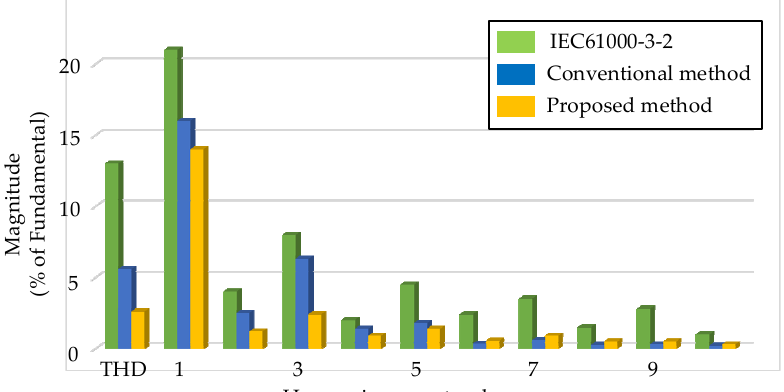
Figure 13. The current harmonics of i g .